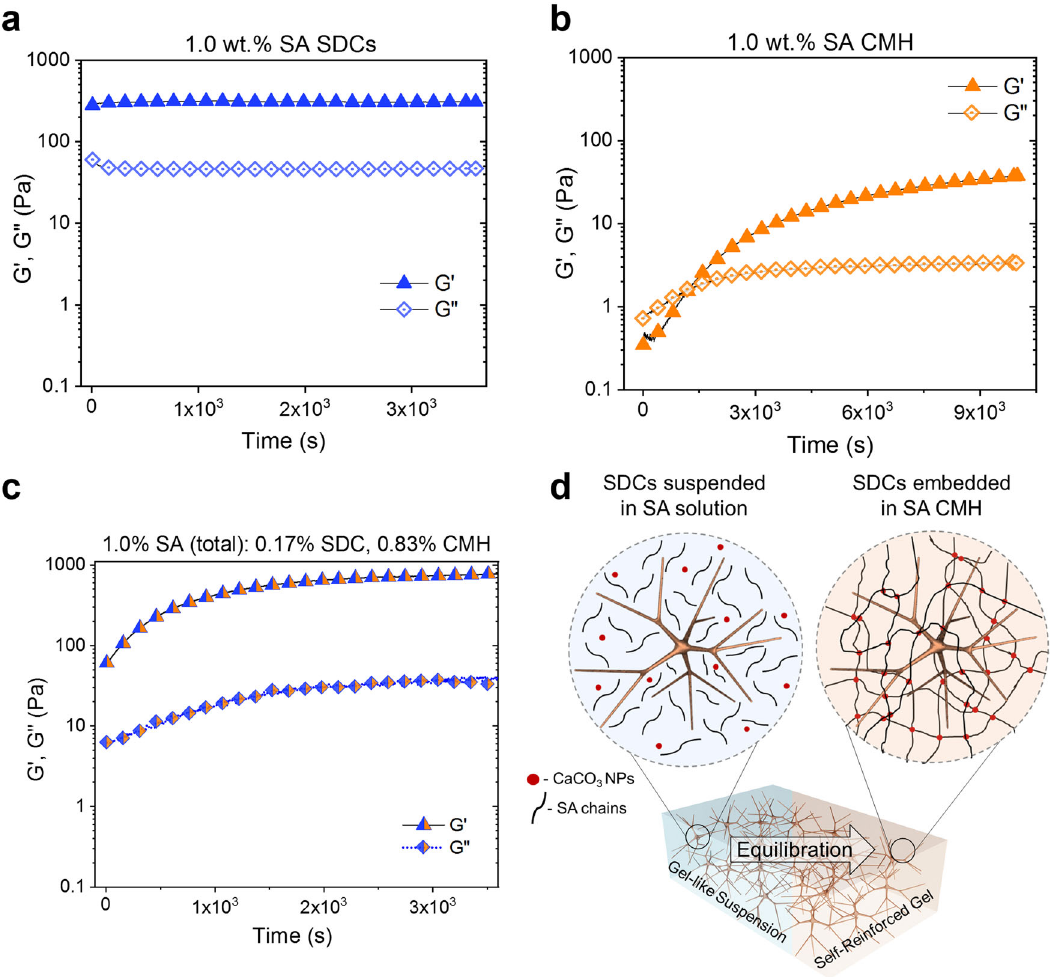
Fig. 4 Time-dependent gelation of SA SDC suspensions, SA CMHs, and SA HHGs. Time sweeps indicating G ’ and G ” (1 rad/s, 1% strain) of a 1.0 wt.% SA SDC suspension in water, b 1.0 wt.% SA CMH following GDL addition and c 1.0 wt.% total SA (0.17 wt.% SDC, 0.83 wt.% CMH) HHG following GDL addition. d Schematic showing the time-dependent transition of a HHG from a colloidal gel to a self-reinforced homocomposite via CMH crosslinking. HHG formulations show immediate, elastic-solid behavior from the colloidal network and further stiffen with the ionic crosslinking of the molecular